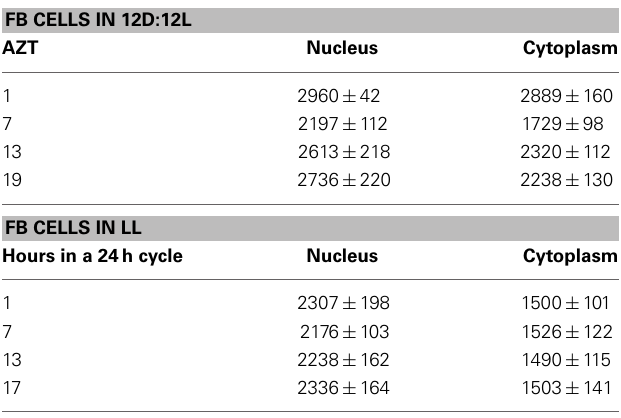
Table 2 | FB cells (mean relative PER fluorescence ± SEM every 6h throughout a day).